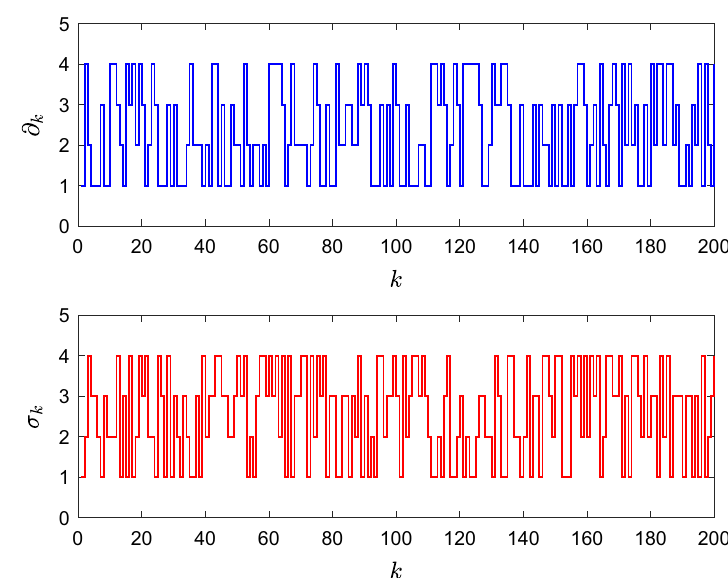
Fig. 4 The modes of the controller and the plant